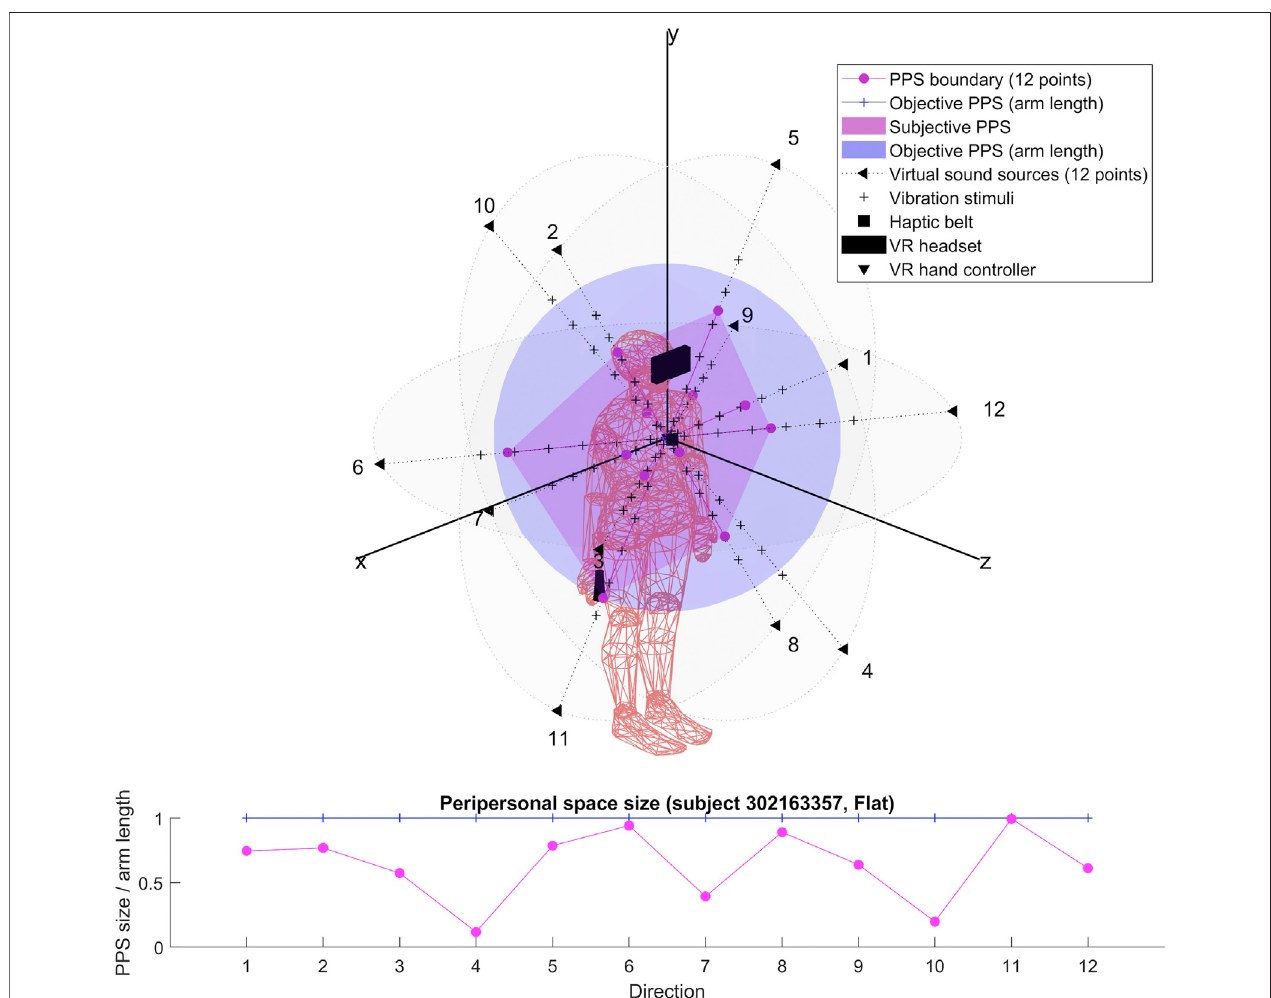
FIGURE 4 | PPS 3D representation for subject 302163357 fl at